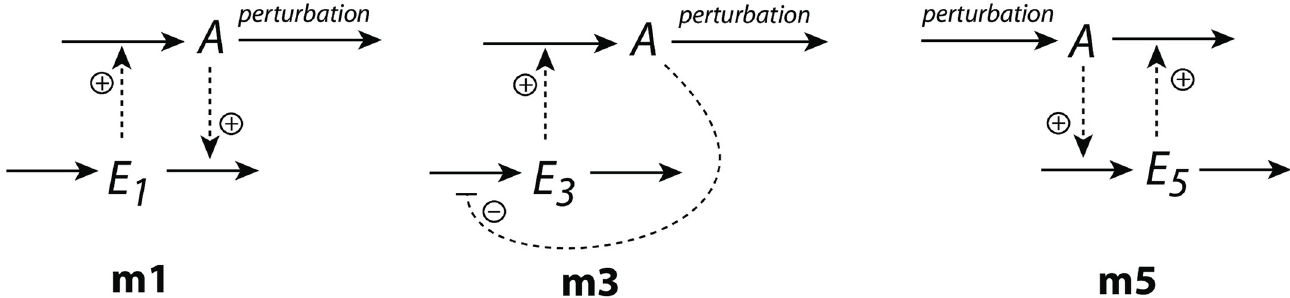
Fig 1. The negative feedback loops m1, m3, and m5 used in this study. Solid arrows indicate reactions/mass flow, while dashed lines indicate activating or inhibiting signaling events. A is the controlled variable, which is kept at a certain set-point by opposing (step-wise) perturbations in A . The E i ’s are controller